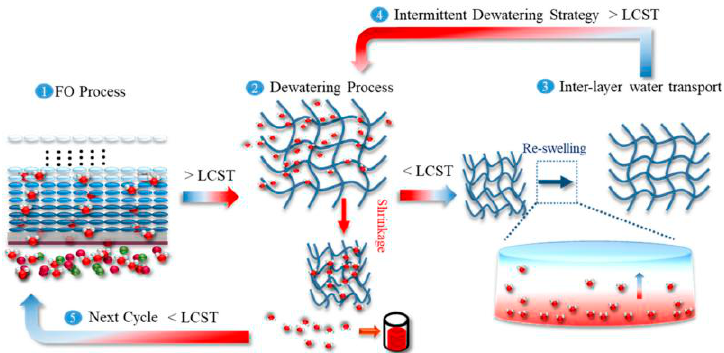
Figure 8. Schematic of continuous semi-batch FO process using bilayer thermo-responsive hydrogels as the draw agent. Reprinted from Reference [66] with permission from Elsevier. LCST: lower critical solution temperature.